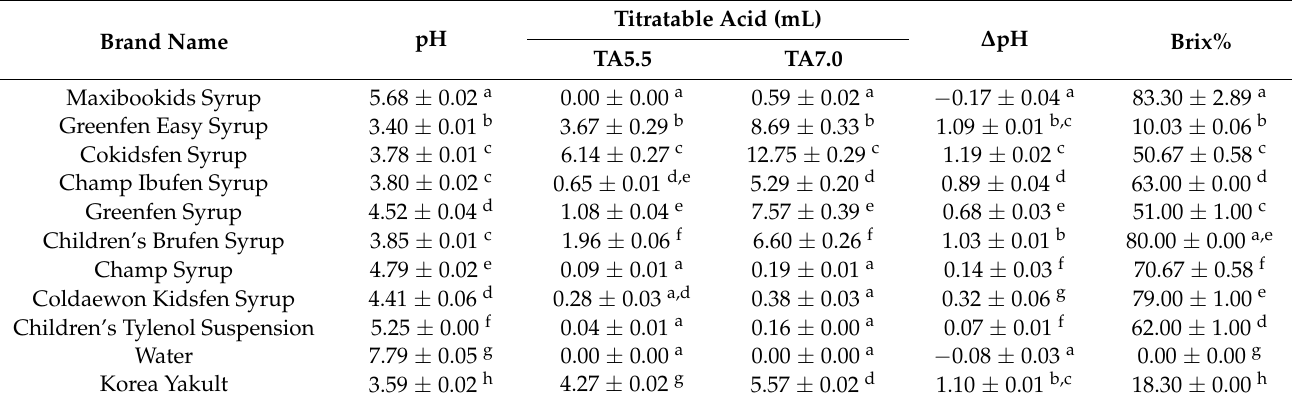
Table 2. Potential for dental erosion from liquid analgesics and